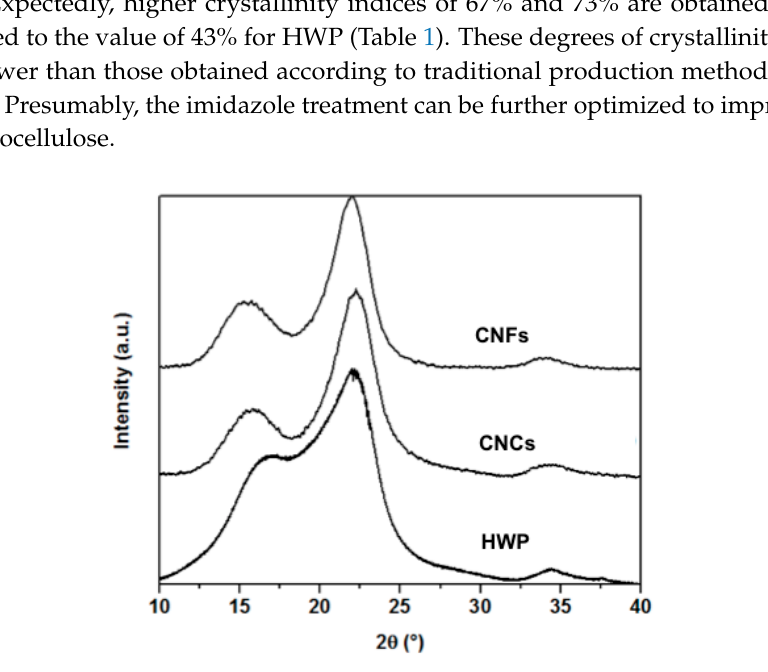
Figure 5. Wide angle X-ray diffraction (WAXD) patterns of the original bleached hardwood pulp (HWP), extracted CNFs and CNCs using 0-imi and 25-imi system, respectively.